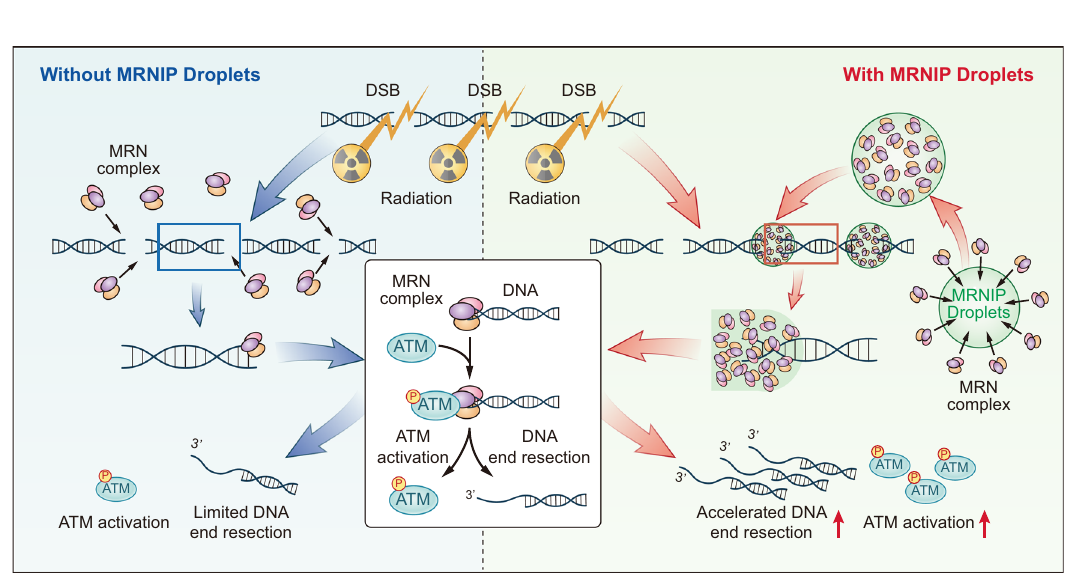
Fig. 8 Model of MRNIP condensates function in DNA damage sensing and end resection. MRNIP condensates concentrate the MRN complex into liquid- like droplets. After DSB formation, these MRNIP droplets move to and incorporate damaged DNA, resulting in rapid binding of DNA to the MRN complex and accelerated ATM activation and DNA end